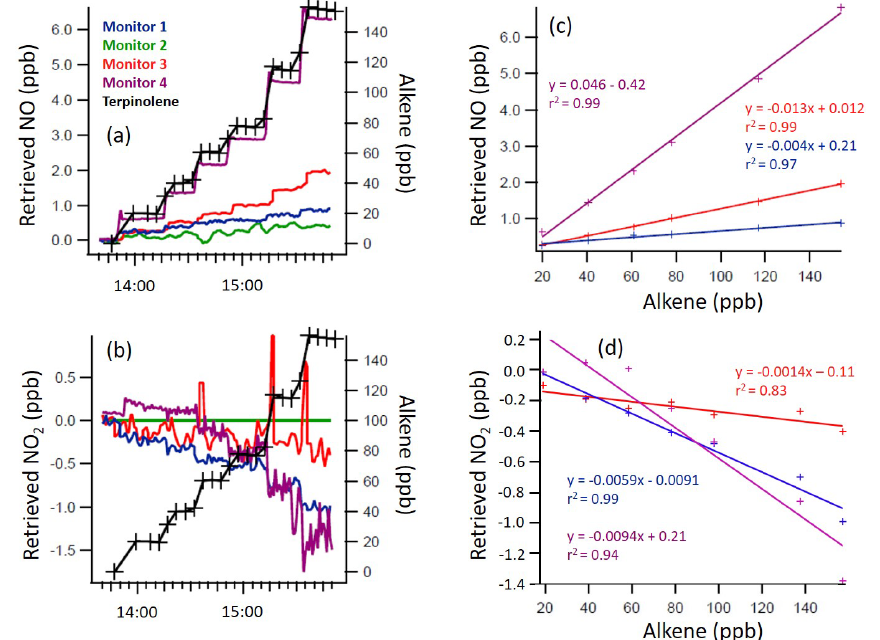
Figure 3. Time series of the terpinolene mixing ratio and measured NO and NO 2 mixing ratios, as retrieved by each monitor (a, b) , with 1min time resolution, and the regression calculations for the monitors that demonstrated significant interference with the addition of terpino- lene (c, d) . Note the different y axis